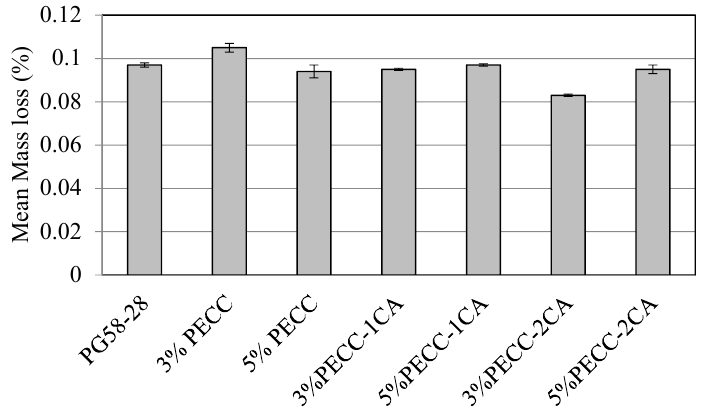
Figure 5. Mass loss test results of each asphalt binder.